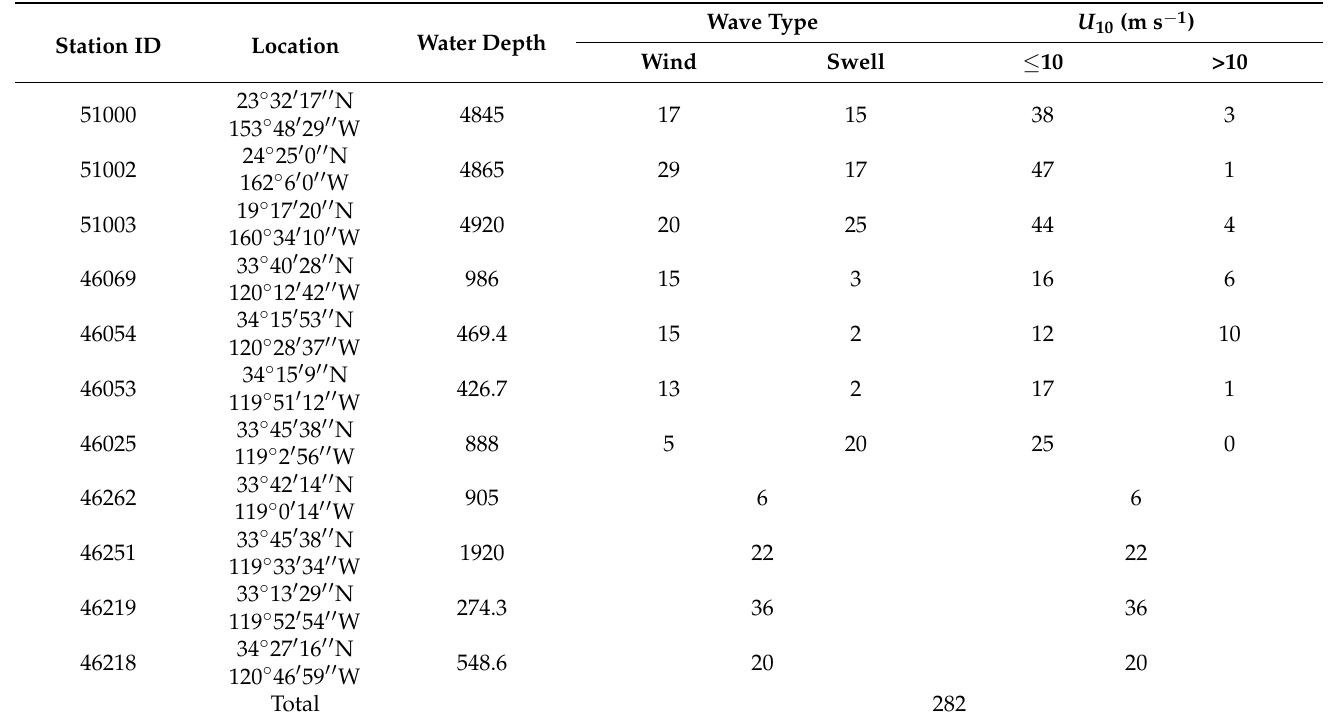
Table 1. NDBC buoy location, water depth, wave type, and wind speed at 10 m height above the sea surface ( U 10 ), as well as the total number of SAR images